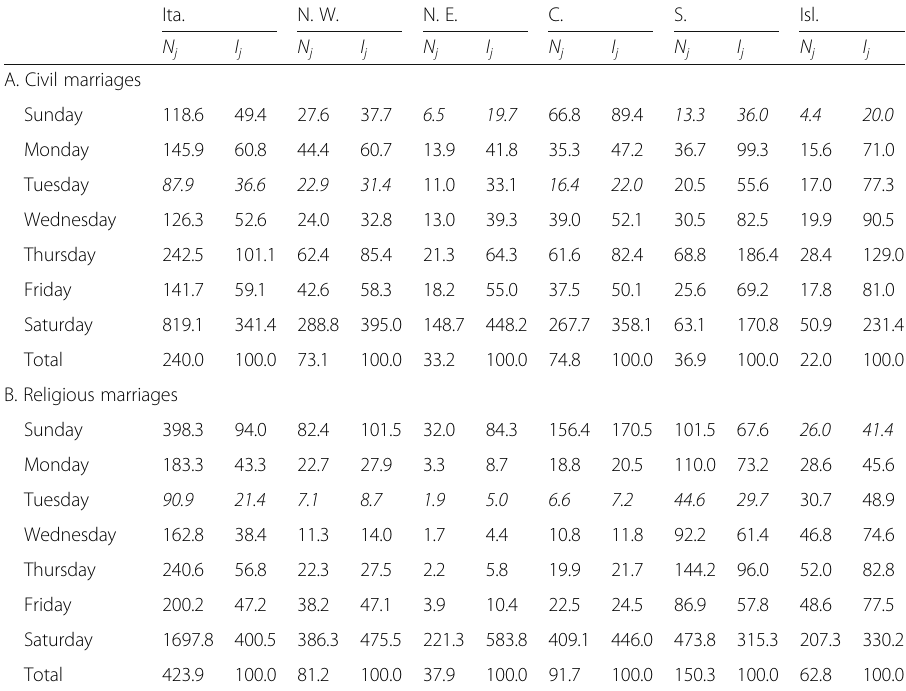
Table 1 Average number of marriages per day of the week, Italy and its macro-areas, 2007-2009 Ita. N.